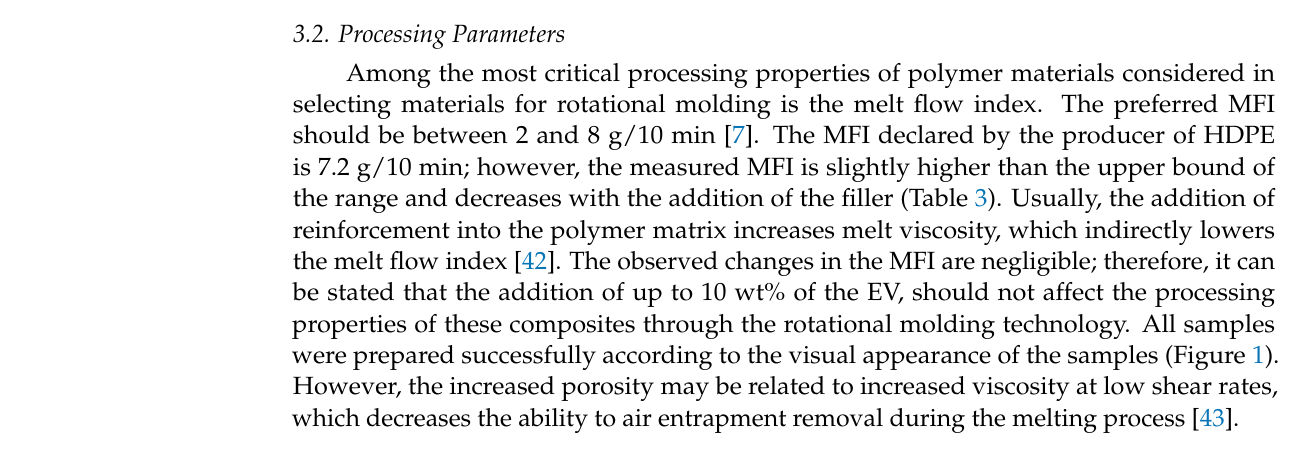
Table 3. The melt flow index for composite samples obtained in melt